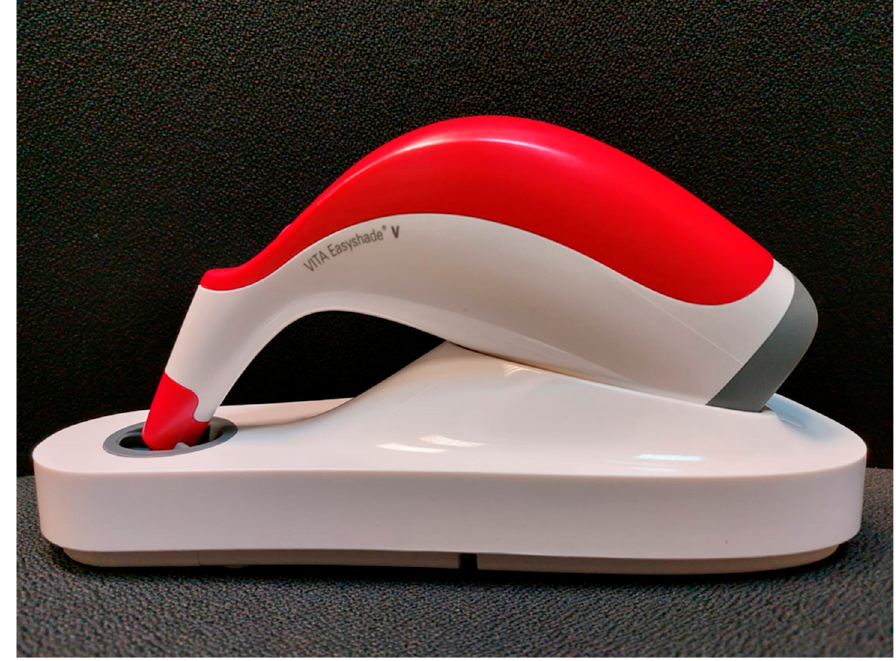
Figure 6. Vita Easyshade ® V, Bad Säckingen, Germany.